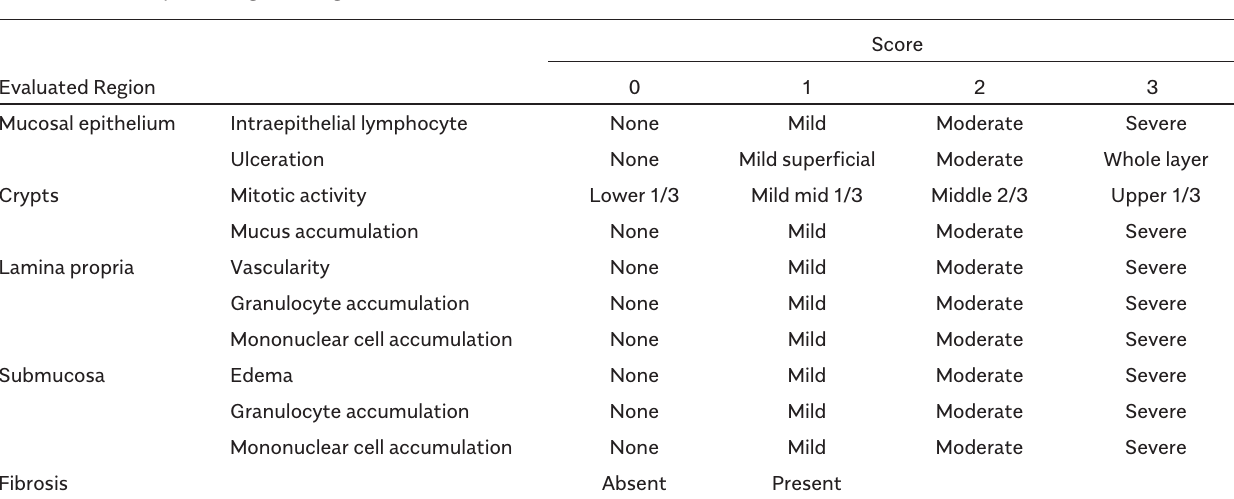
Table 1. Microscopic Damage Scoring